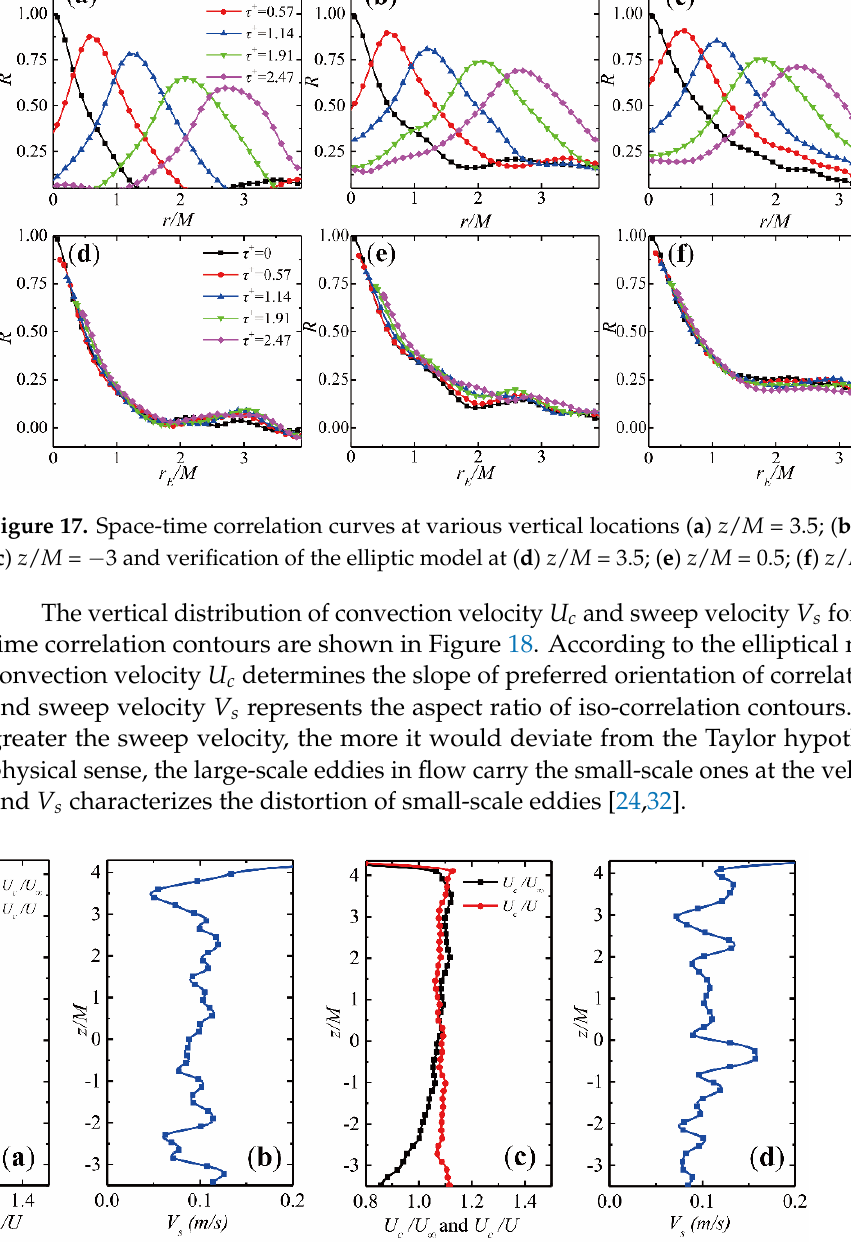
Figure 18. Vertical distribution of convection velocities at ( a ) x / M = 8 ( c ) x / M = 20 and sweep velocities at( b ) x / M = 8 ( d ) x / M = 20, red ( U c / U ), black ( U c / U ∞ ), blue ( V s ).